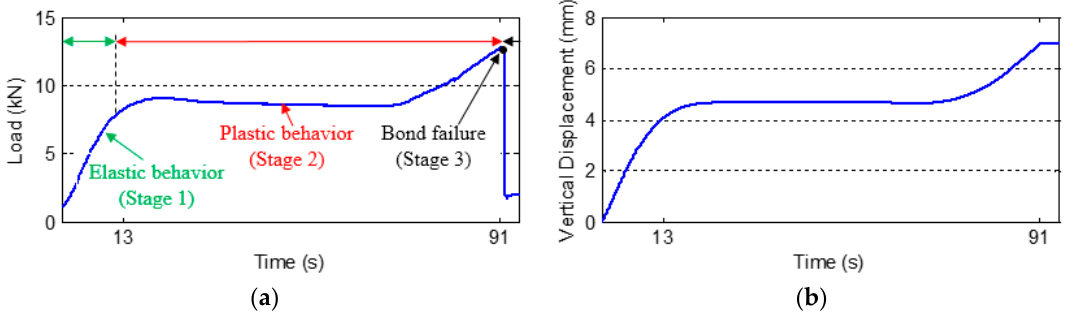
Figure 5. Loading results. ( a ) Load vs. Time. ( b ) Displacement vs. Time.